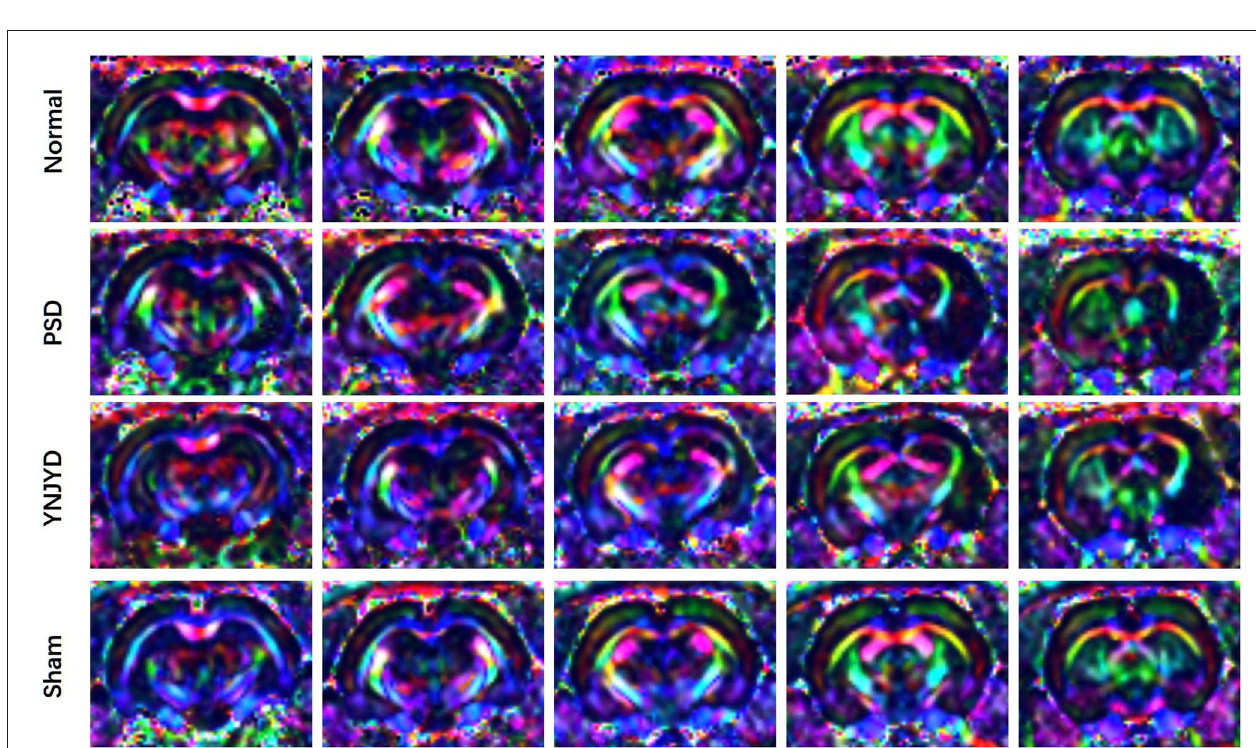
FIGURE 5 | Representative color-encoded fractional anisotropy (FA) directional maps from continuous scanning in normal, post-stroke depression (PSD), YNJYD-treated, and sham-operated rats.